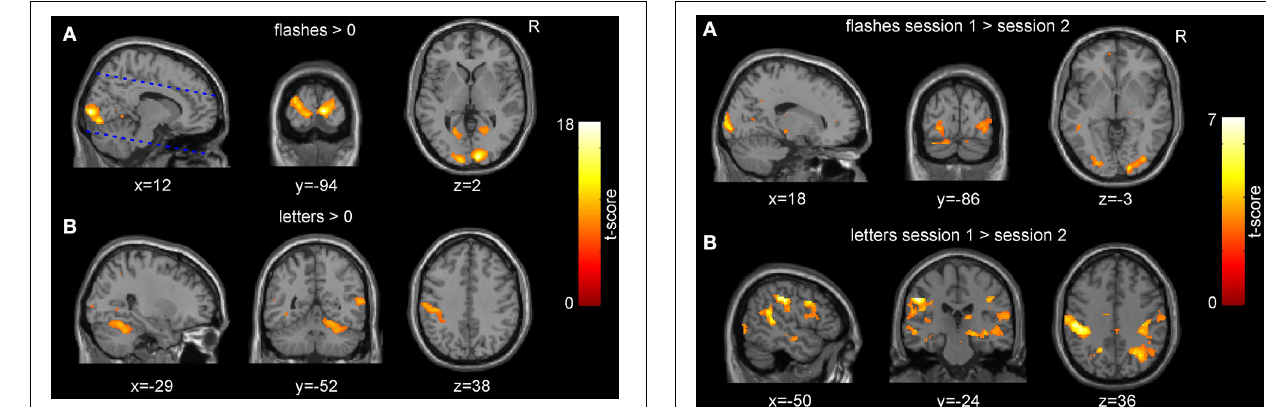
FIGURE 3 | Group-level session effects. Neuronal responses in the visual cortex to pattern flashes (A) and those to letters and button presses (B) were significantly decreased in the post- compared to the pre-high frequency stimulation (HFS) session ( p < 0 . 01, uncorrected for multiple comparisons for display